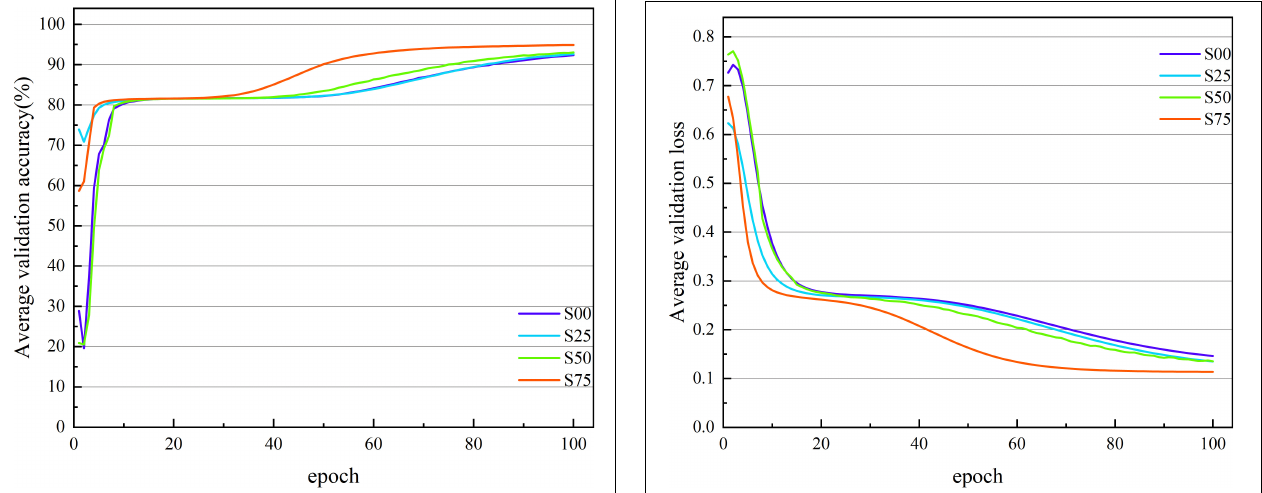
FIGURE 4 | The average verification loss curve under different segmentation overlap rates. The abscissa is the number of iterations, whose range of values is from 1 to 100; and the ordinate is the average verification loss rate, whose range of values is from 0.771 to